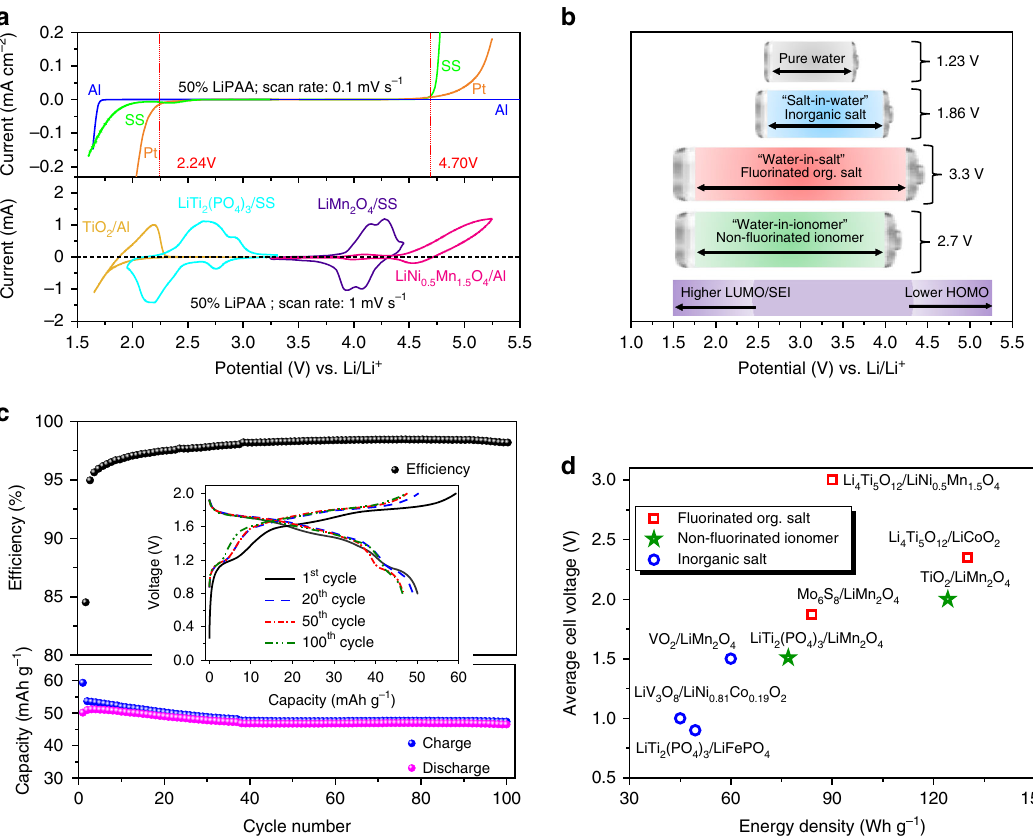
Fig. 5 50wt% ‘ water-in-ionomer ’ gel as lithium-ion electrolyte. a Electrochemical stability windows of the 50 wt% LiPAA electrolyte measured on Pt, stainless steel (SS) and Al as well as cyclic voltammograms of TiO 2 , LiTi 2 (PO 4 ) 3 , LiMn 2 O 4 and LiNi 0.5 Mn 1.5 O 4 on various current collectors as indicated in the graph. Scan rate: 0.1 mV s − 1 . b Comparison of aqueous lithium-ion battery end-of-charge voltages with various salts. The “ salt-in-water ” electrolyte correspond to 1 M Li 2 SO 4 in a LiTi 2 (PO 4 ) 3 /LiMn 2 O 4 cell 39 , the “ water-in-salt electrolyte ” corresponds to Li(TFSI) 0.7 (BETI) 0.3 ·2H 2 O in a Li 4 Ti 5 O 12 / LiNi 0.5 Mn 1.5 O 4 cell 22 , and the “ water-in-ionomer ” corresponds to the 50 wt% LiPAA gel electrolyte in a TiO 2 /LiMn 2 O 4 cell. c . Evolution of speci fi c capacities and coulombic ef fi ciencies of a LiTi 2 (PO 4 ) 3 /LiMn 2 O 4 battery cell at 0.5 C. Current collectors: SS. The weight refers to both electrodes. Insert: Voltage pro fi les for selected cycles as indicated on the graph. d Performance data of aqueous lithium-ion batteries based on various electrochemical couples. LiTi 2 (PO 4 ) 3 /LiFePO 4 40 , LiV 3 O 8 /LiNi 0.81 Co 0.19 O 2 41 , VO 2 /LiMn 2 O 4 18 , Mo 6 S 8 /LiMn 2 O 4 20 , Li 4 Ti 5 O 12 /LiCoO 2 and Li 4 Ti 5 O 12 /LiNi 0.5 Mn 1.5 O 4 22 . Insert: Energy densities for selected aqueous electrolytes for